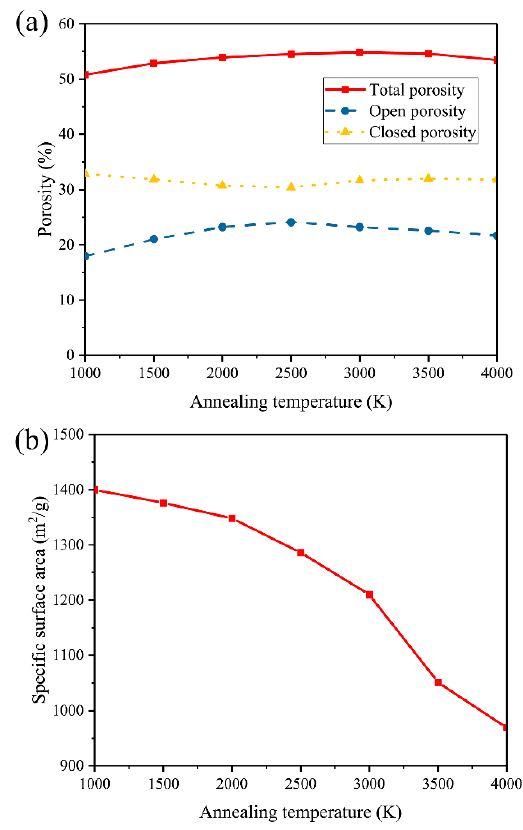
Figure 5. The porosity ( a ) and specific surface area ( b ) of disordered graphene networks (DGNs) annealed at different temperatures.